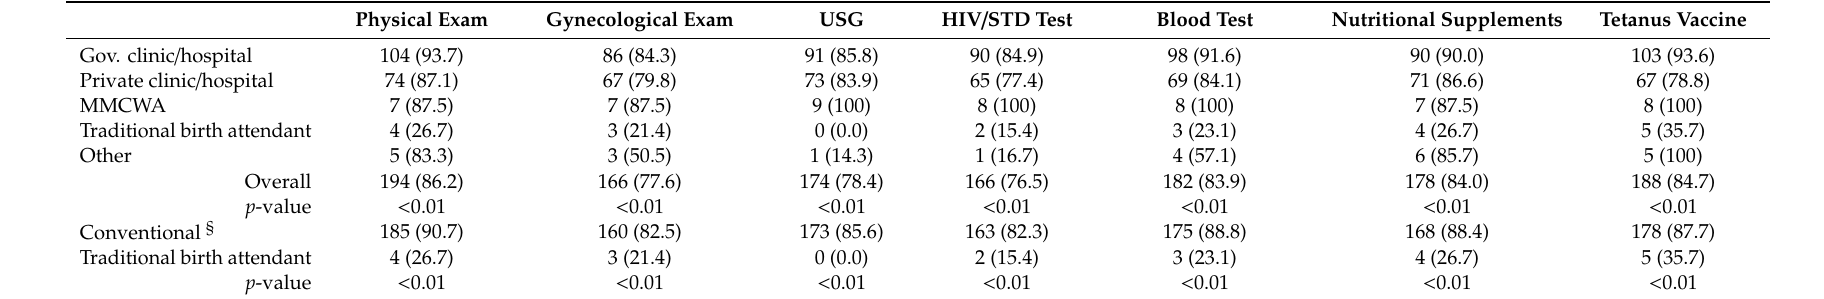
Table 3. Women receiving essential antenatal care services by type of health care